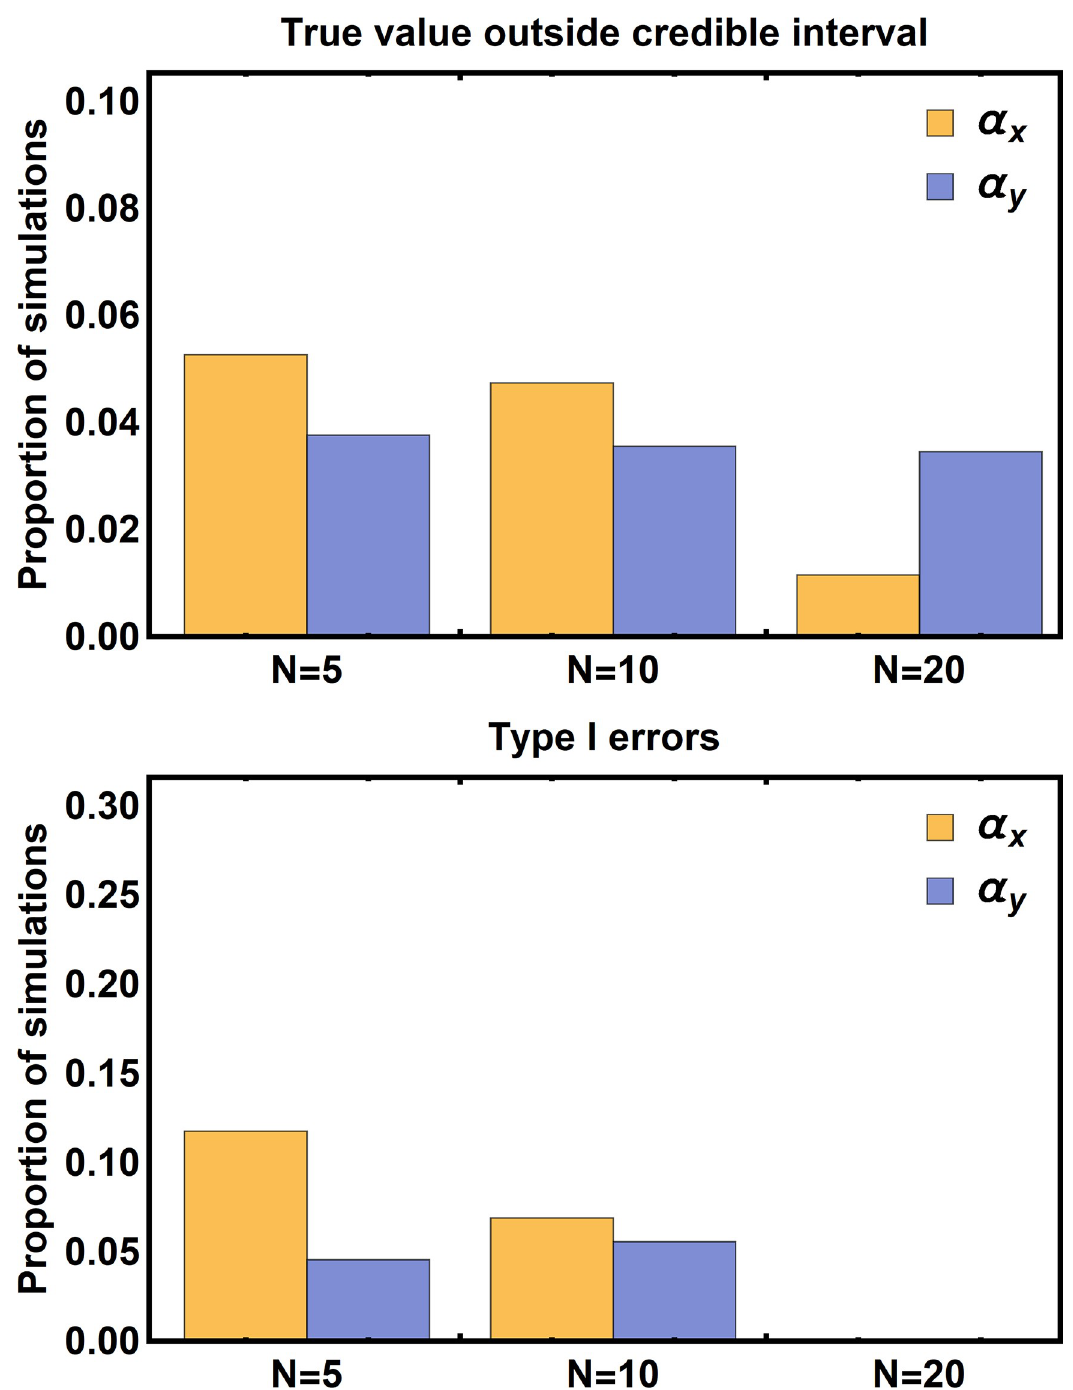
Fig 4. The proportion of simulations where the true value of the parameter fell outside of the 95% credible interval of its posterior distribution (top panel) and the proportion of simulations where the true value of the parameter was equal to zero, but the credible interval did not include zero (bottom panel). Inference was performed assuming independent estimates for background parameters were available, allowing narrower prior distributions to be used than in Fig 2.